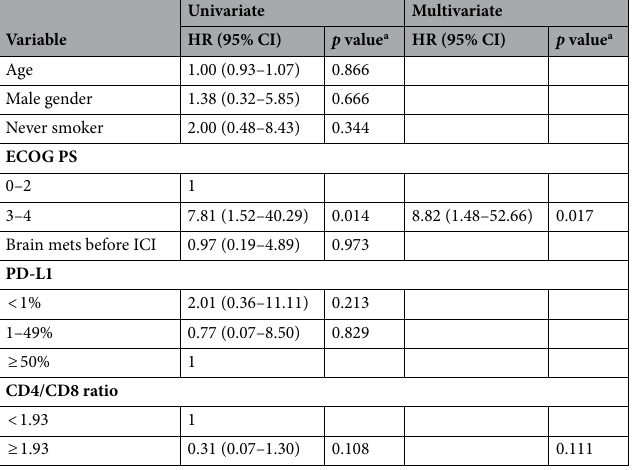
Table 3. Univariate and multivariate analyses of risk factors for overall survival. ECOG PS, Eastern Cooperative Oncology Group performance status; mets, metastasis; ICI, immune checkpoint inhibitor; HR, hazard ratio; CI, confidence interval. a Probability value by Cox regression model.